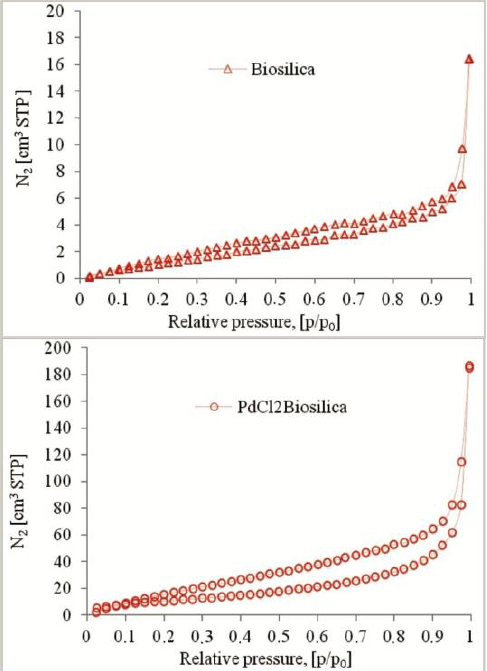
Figure 2. N 2 adsorption isotherms of the pure diatom biosilica and palladium(II) chloride-doped diatom biosilica.